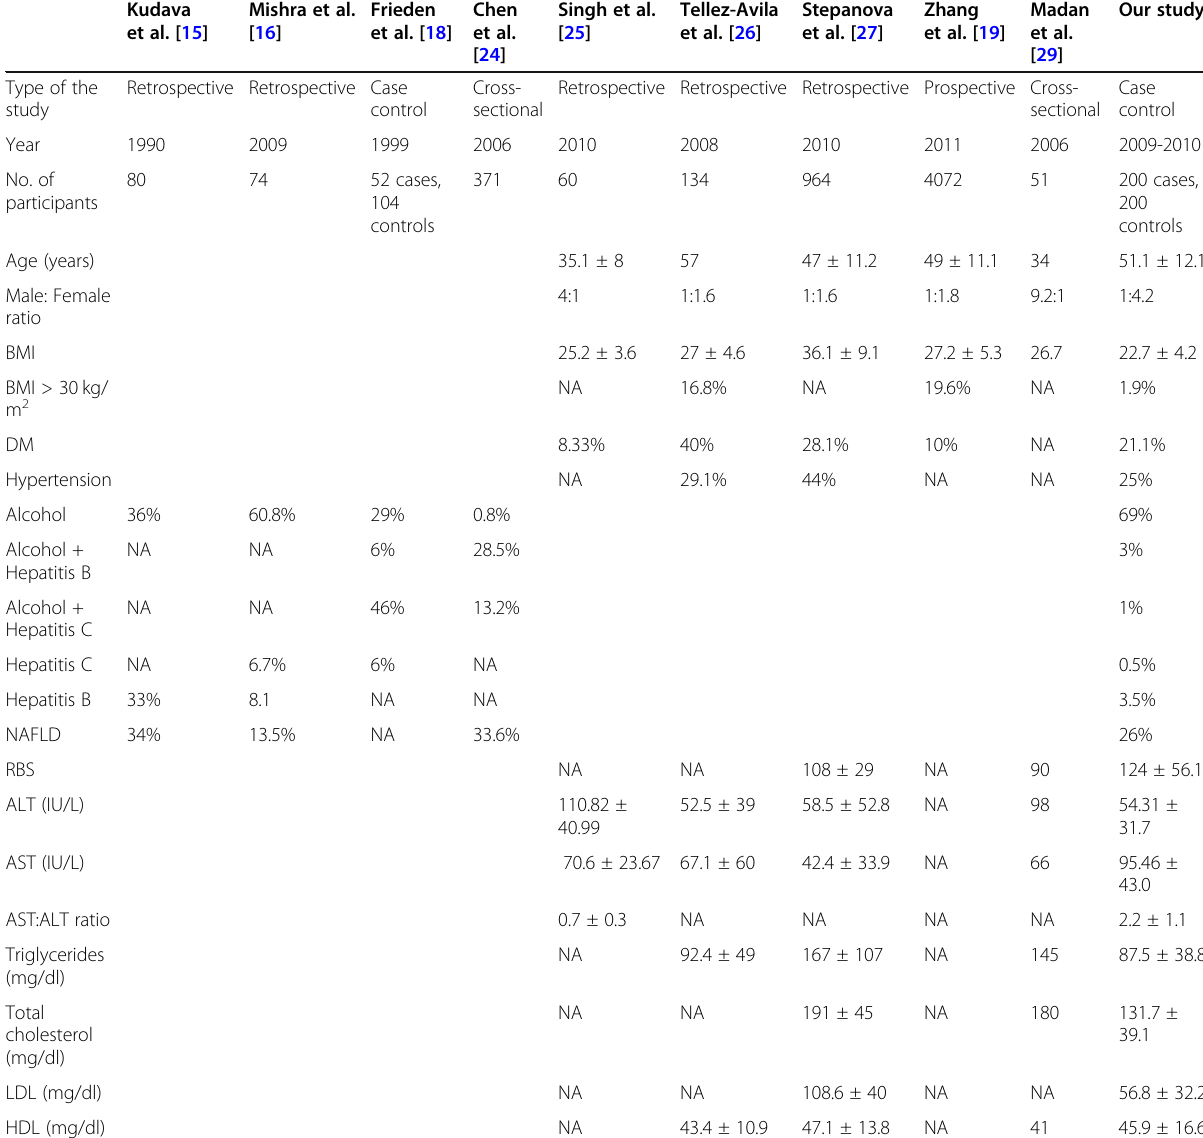
Table 4 Comparison of various studies with present study on risk factors of chronic liver disease Kudava et al.